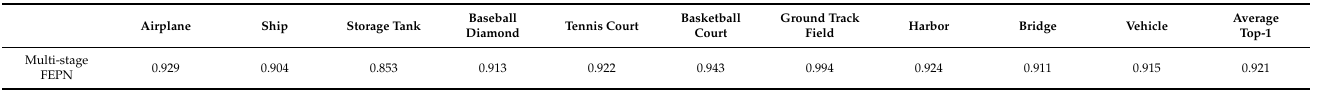
Table 4. The top-1 detection accuracy for each category and average top-1 detection accuracy of Multi-stage